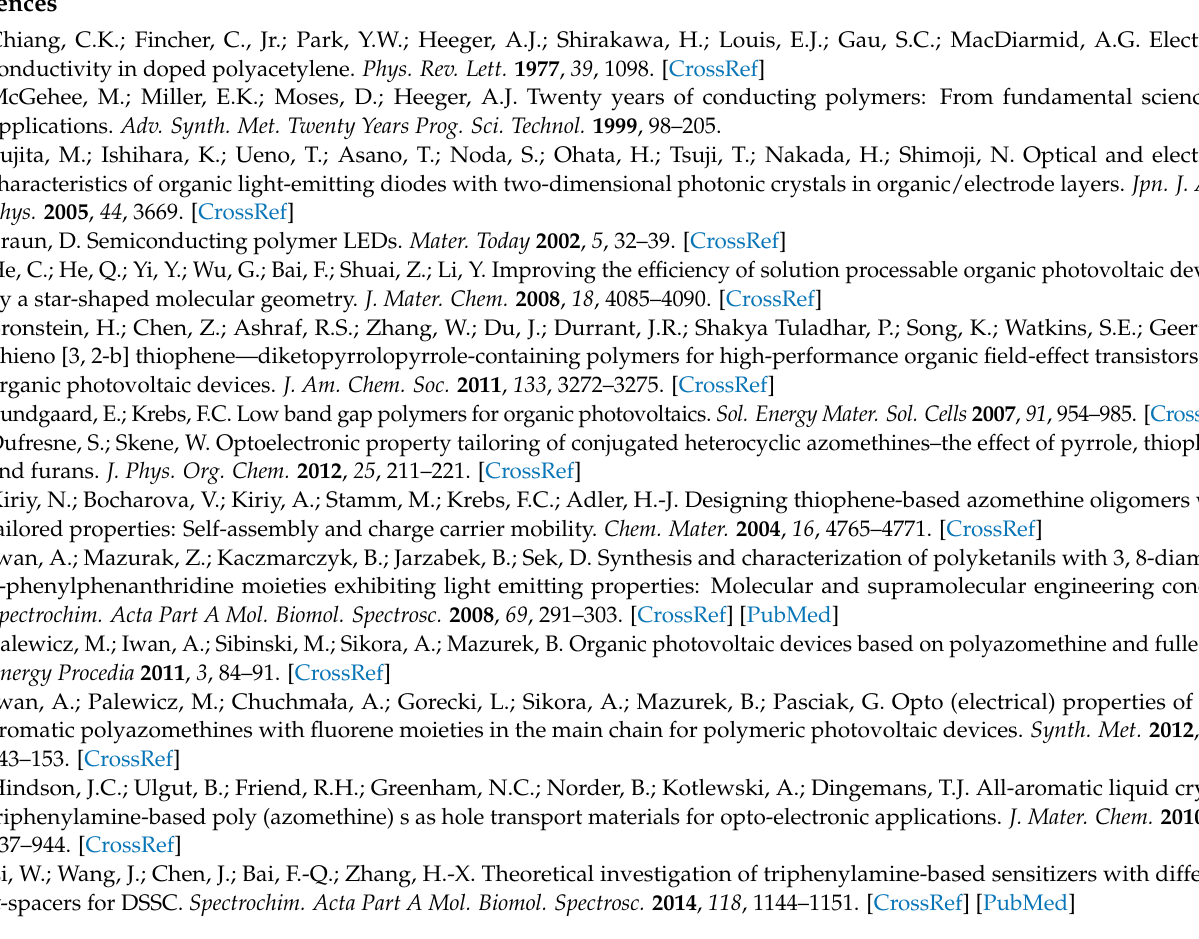
(a) TPA-DT (b) TPA-tHB (c) TPA-dHB. Figure S5. CV scans (a) TPA-DT during oxidation, (b) TPA-DT during reduction, (c) TPA-tBH and (d) TPA-dBH during oxidation processes (0.1 mol/dm 3 Bu 4 NPF 6 in CH 2 Cl 2 with Pt). Figure S6. Calculated geometries of (a) TPA-dHB, (b) TPA-tHB (c) TPA-DT. Figure S7. Contours of HOMO and LUMO of imines. Figure S8. DOS spectra of the imines. Figure S9. Absorption spectra of TPA-DT, TPA-tHB and TPA-dHB in (a) C 6 H 5 Cl and (b) CH 2 Cl 2 . Figure S10. Emission spectra of (a) TPA-DT, (b) TPA-tHB and (c) TPA-dHB in CHCl 3 and CH 2 Cl 2 . Figure S11. The photocurrent-density voltage curves of tested devices. Table S1. Composition of the selected molecular orbitals of TPA compounds. Table S2. Mean plane angles for TPA molecules. Table S3. Calculated dipole moments [D] in ground and S 1 states in solvents. Table S4. The calculated electronic transitions corresponding to excitation resulting luminescence in chloroform